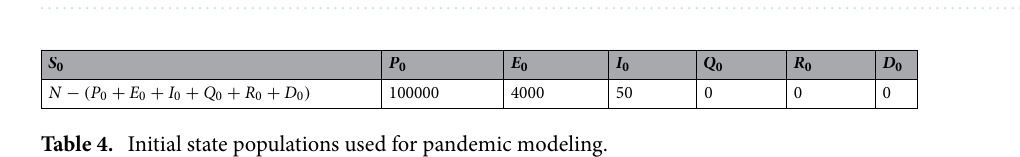
Figure 8. Intervention by intervention optimization of pandemic model.